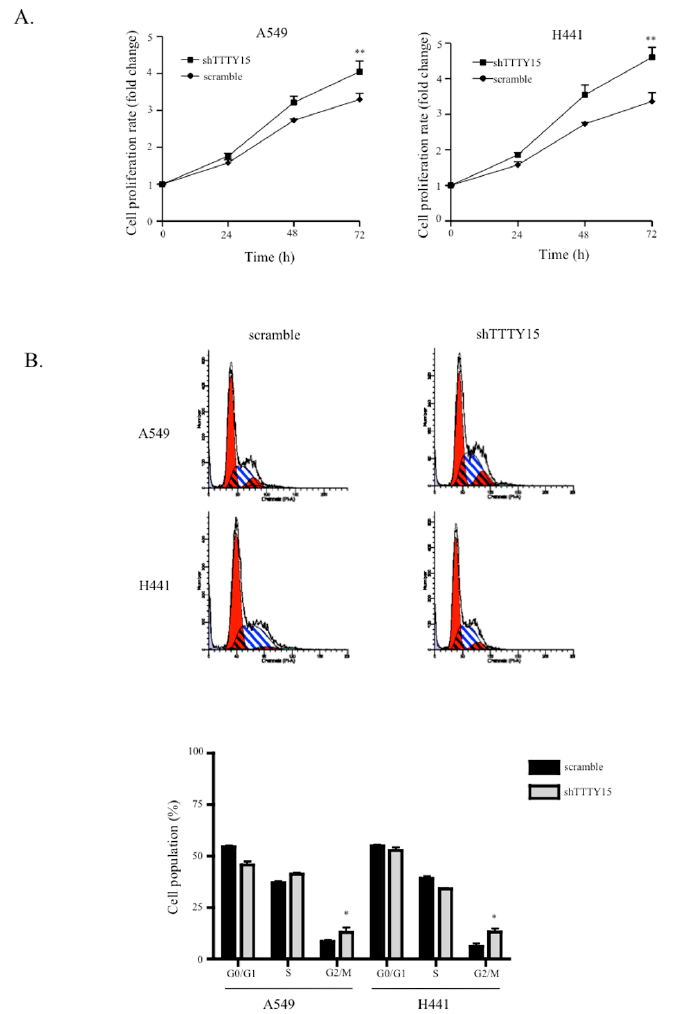
Figure 2 . The TTTY15 knockdown increases cell proliferation and cell cycle progression. ( A ) The 3- (4,5-dimethylthiazol-2-yl)-2,5-diphenyltetrazolium bromide (MTT) assay shows that the TTTY15